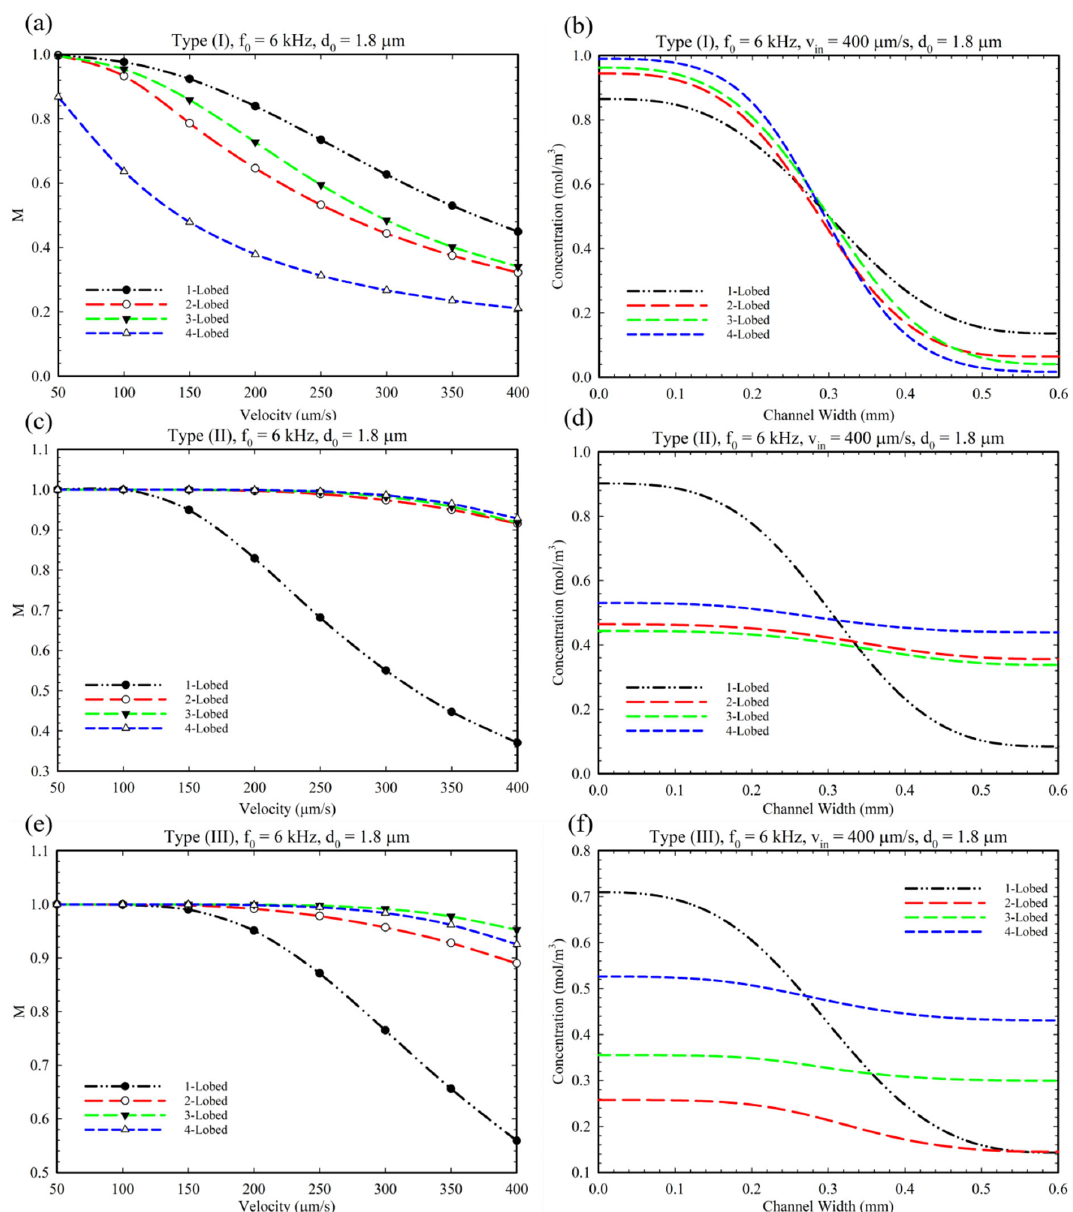
Figure 7. The diagram of the effect of inlet velocity on MI. ( a , c , e ) for type I, II, and III for multi-lobed structures. ( b , d , f ) The corresponding concentration profile at the outlet cross ‐ section.